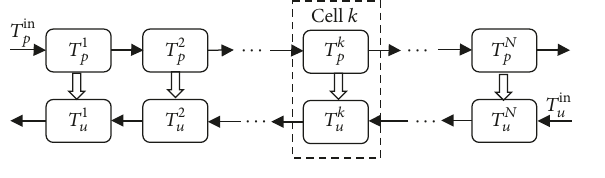
Figure 2: 𝑁 cell